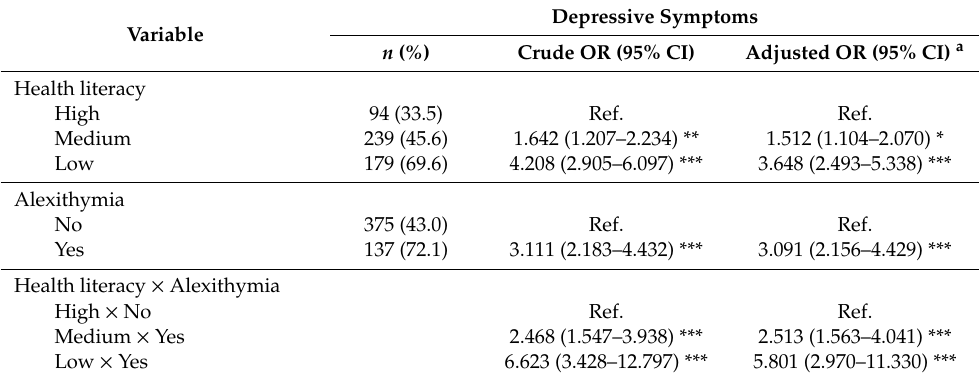
Table 2. The e ff ect of health literacy and alexithymia on depressive symptoms in the students.